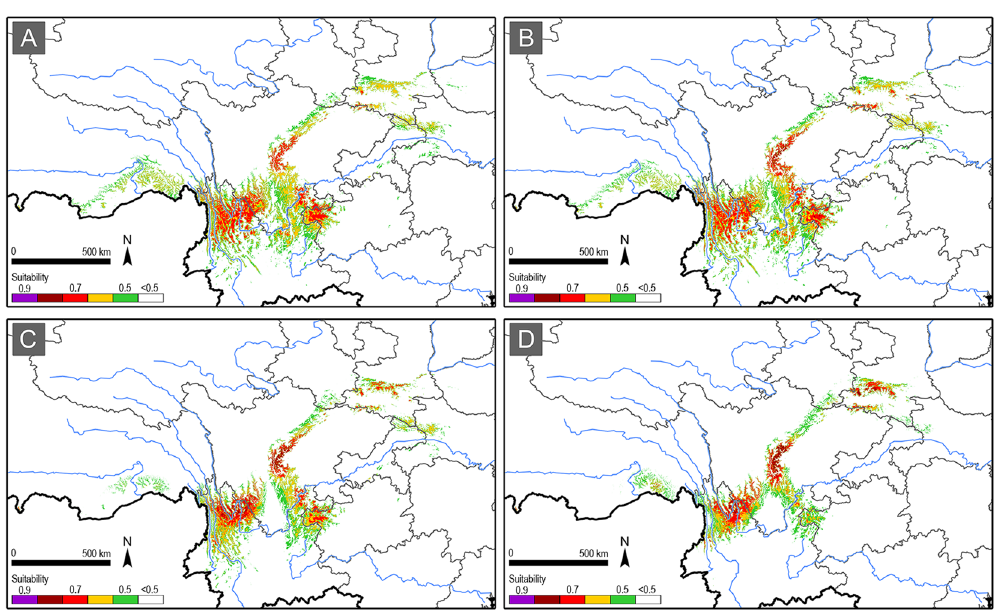
Figure 5. The suitable areas for B. thaidina in China in the 2070 s under the RCP2.6 ( A ), RCP4.5 ( B ), RCP6.0 ( C ), and RCP8.5 ( D )